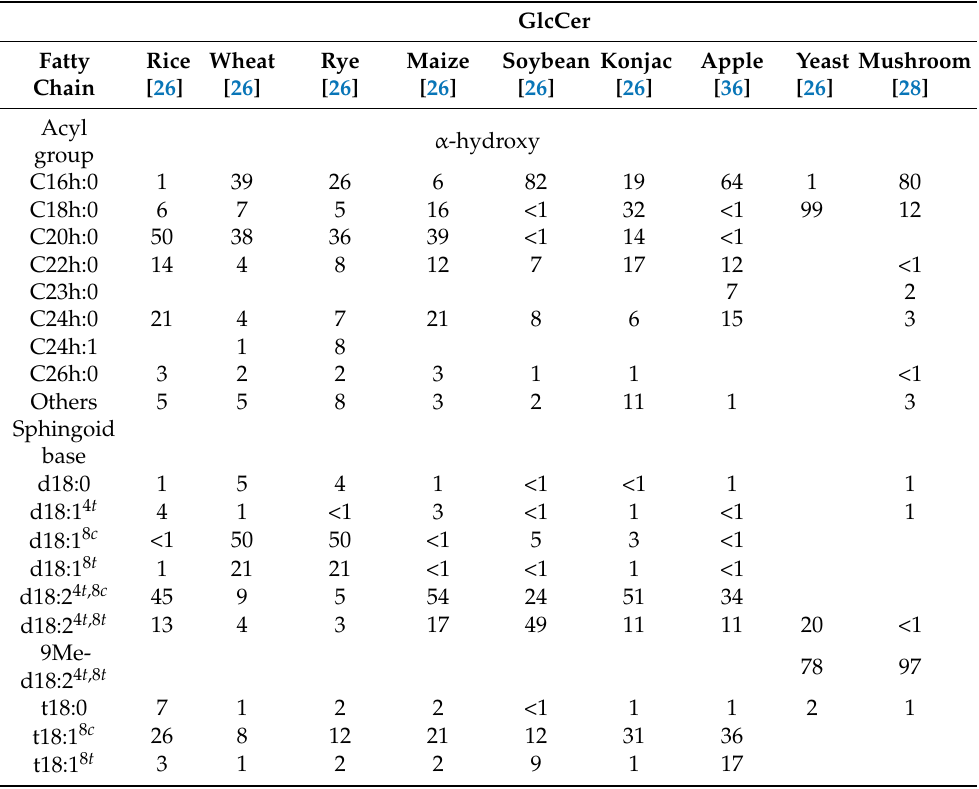
Table 2. Fatty chain composition (mol%) of plant- and fungi-derived glucosylceramides